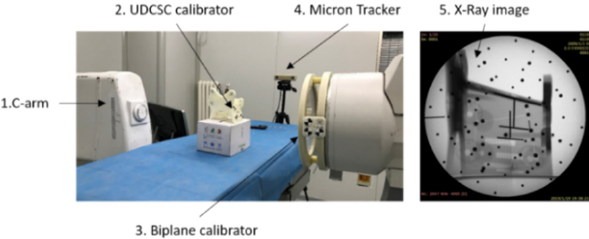
Figure 13. Comparison between UDCSC calibrator and biplane calibrator.